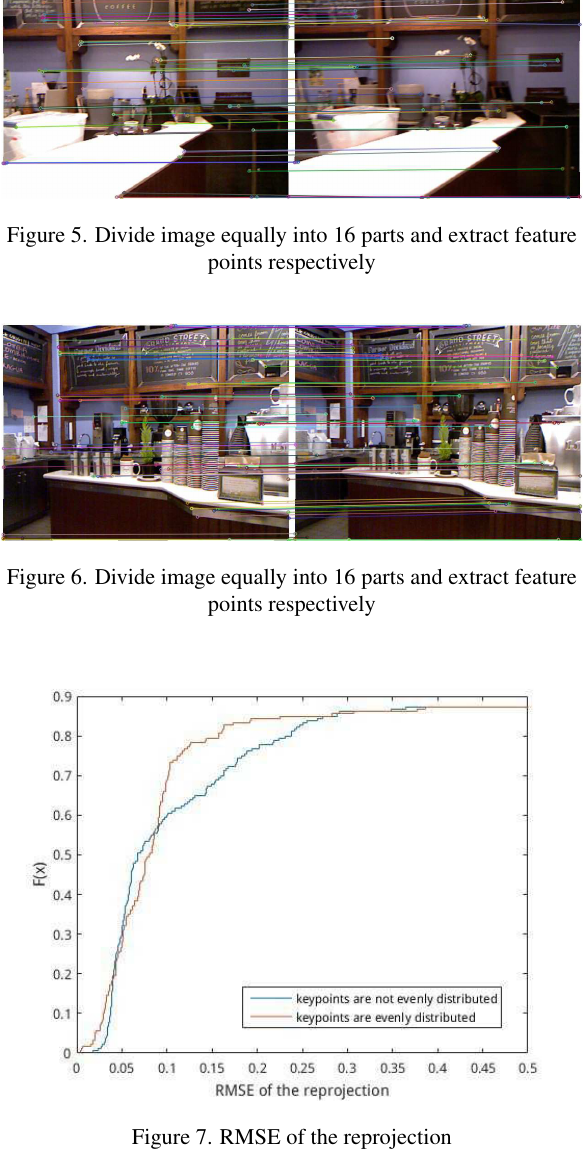
Figure 3. Extract feature points in whole image and good matches condition is 5 times the minimum distance